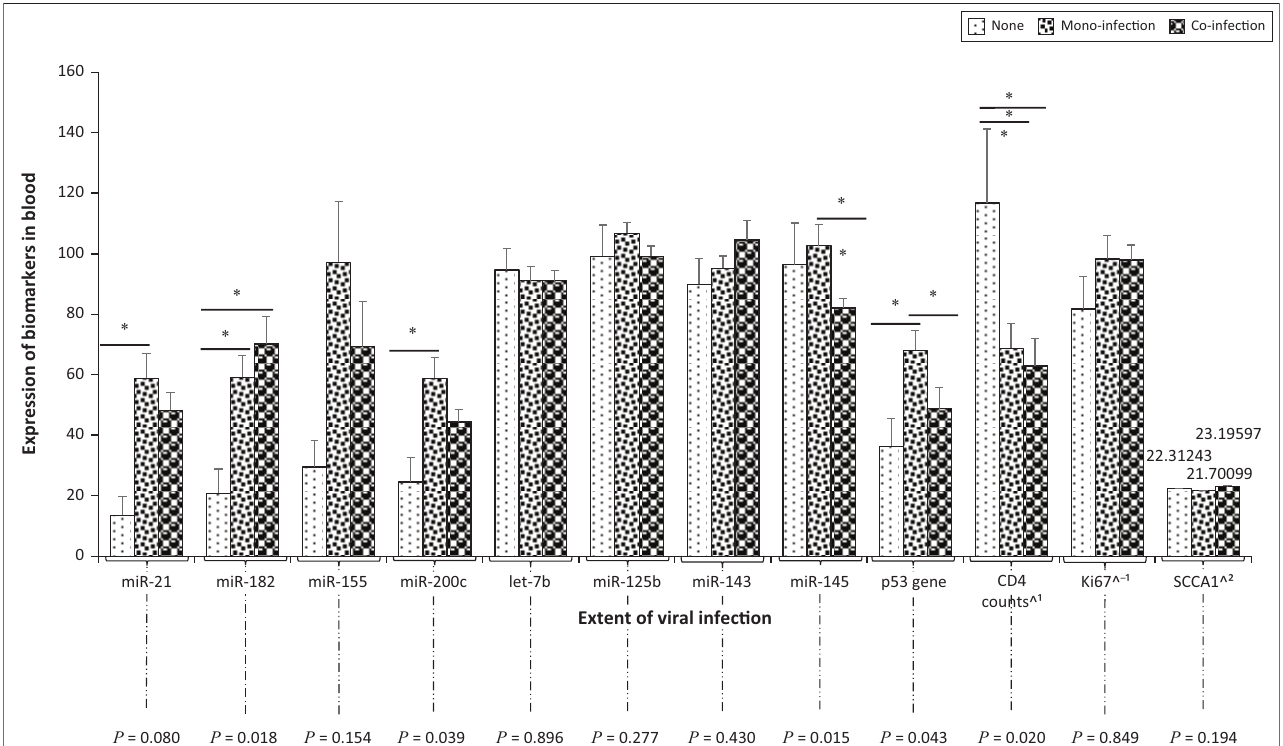
FIGURE 4: Expression of biomarkers among individuals with viral mono-infection or co-infection, in the absence of the target viruses, Ogun State, Nigeria, 2018. Expression of miR-21, miR-155, miR-200c, p53 gene and Ki67 were higher among participants with viral mono-infection than among those with viral co-infection; miR-182 and miR-143 were higher among participants with viral co-infection than among those with mono-infections; miR-let-7b was lower among participants with viral co- infection than among those with mono-infections; miR-125b expression was higher among participants with viral mono-infection than among those with viral co-infection; miR-145 expression was higher among participants with viral mono-infection and lower among those with viral co-infection, CD4 + T-cell counts was lower among participants with viral co-infection than among those with viral mono-infection; SCCA1 level was higher among participants with viral co-infection and lower among those with viral mono-infection; when compared with those who had no viral